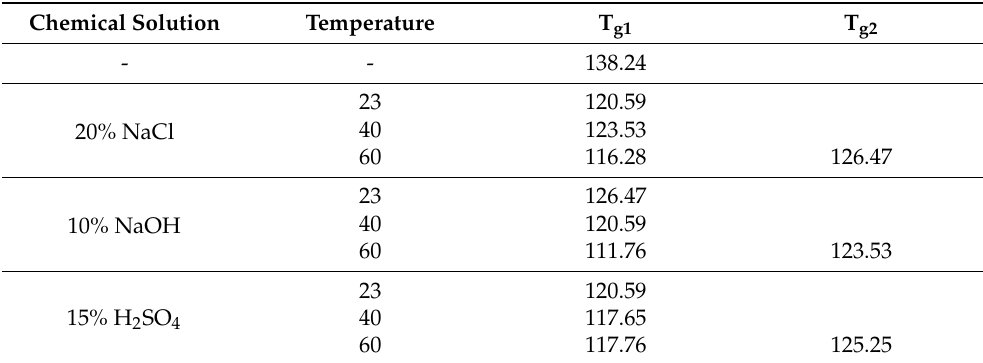
Table 5. The glass transition temperature is determined by the dependence of the tan delta on